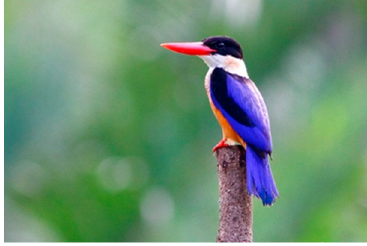
Figure 2. Black-capped Kingfisher.